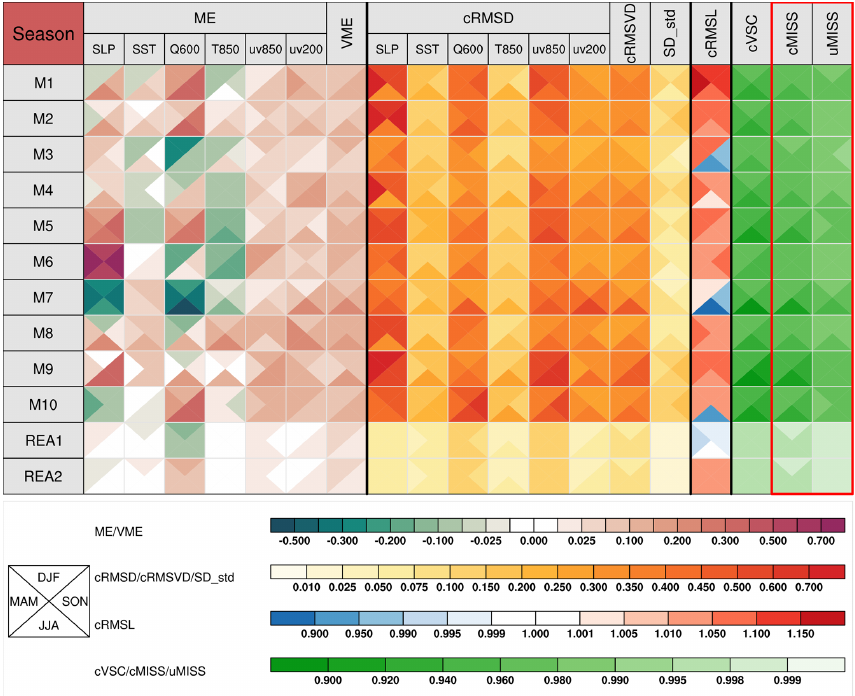
Figure 6. Metrics table of centered statistics. These models are used to simulate climatological means of 600hPa specific humidity (Q600), SLP, SST, 850hPa temperature (T850), 850hPa winds (uv850) and 200hPa winds (uv200), of the Northern Hemisphere in four sea- sons, spring (March–April–May), summer (June–July–August), autumn (September–October–November), and winter (December–January– February). Each square is divided into four triangles, representing model performance in different seasons, as shown in the bottom-left legend. The colored bars for different statistical metrics are shown below the